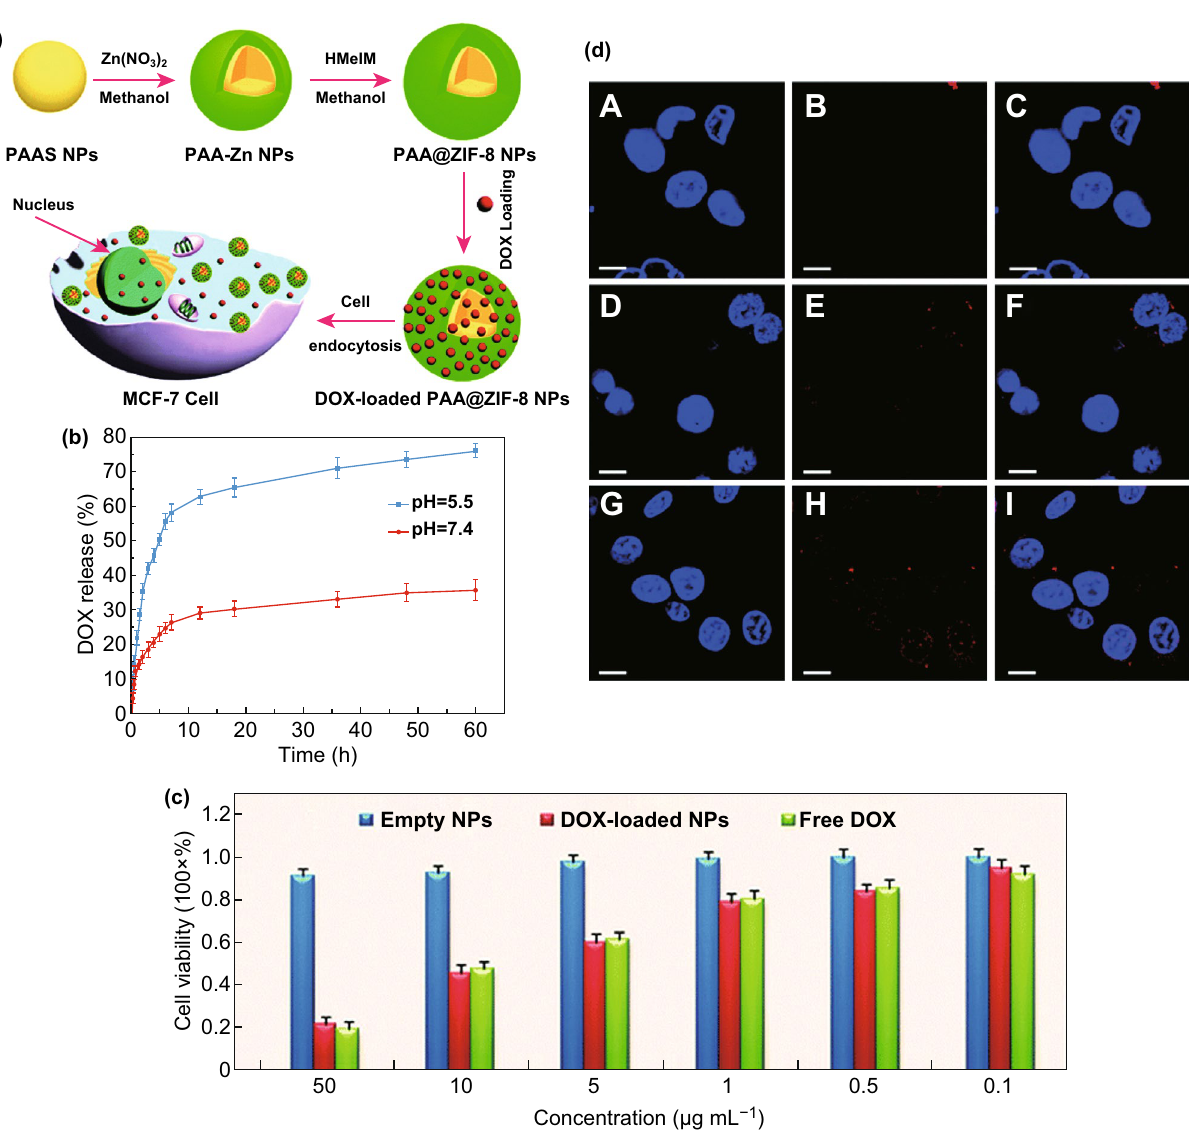
Fig. 4 a Schematic illustration of the synthesis of PAA@ZIF-8 as the nanocarrier for DOX drug loading and pH-controlled release. b Drug release of DOX-loaded PAA@ZIF-8 at pH 5.5 and 7.4 at 37 °C. c In vitro cytotoxicity of PAA@ZIF-8, DOX-loaded PAA@ZIF-8, and free DOX against MCF-7 cells at different concentrations after 24 h. d CLSM images of MCF-7 cells incubated with DOX-loaded PAA@ZIF-8 ([DOX] = 20 μg mL −1 ) for 3 h (A–C), 12 h (D–F) and 24 h (G–I) at 37 °C, respectively. Columns 1–3 can be classified to cell nucleus (dyed in blue by Hoechst 33,342), DOX-loaded PAA@ZIF-8, and the merged images of both, respectively. All scale bars are 10 μm. Reproduced with permission from Ref. [34]. Copyright 2014, The Royal Society of